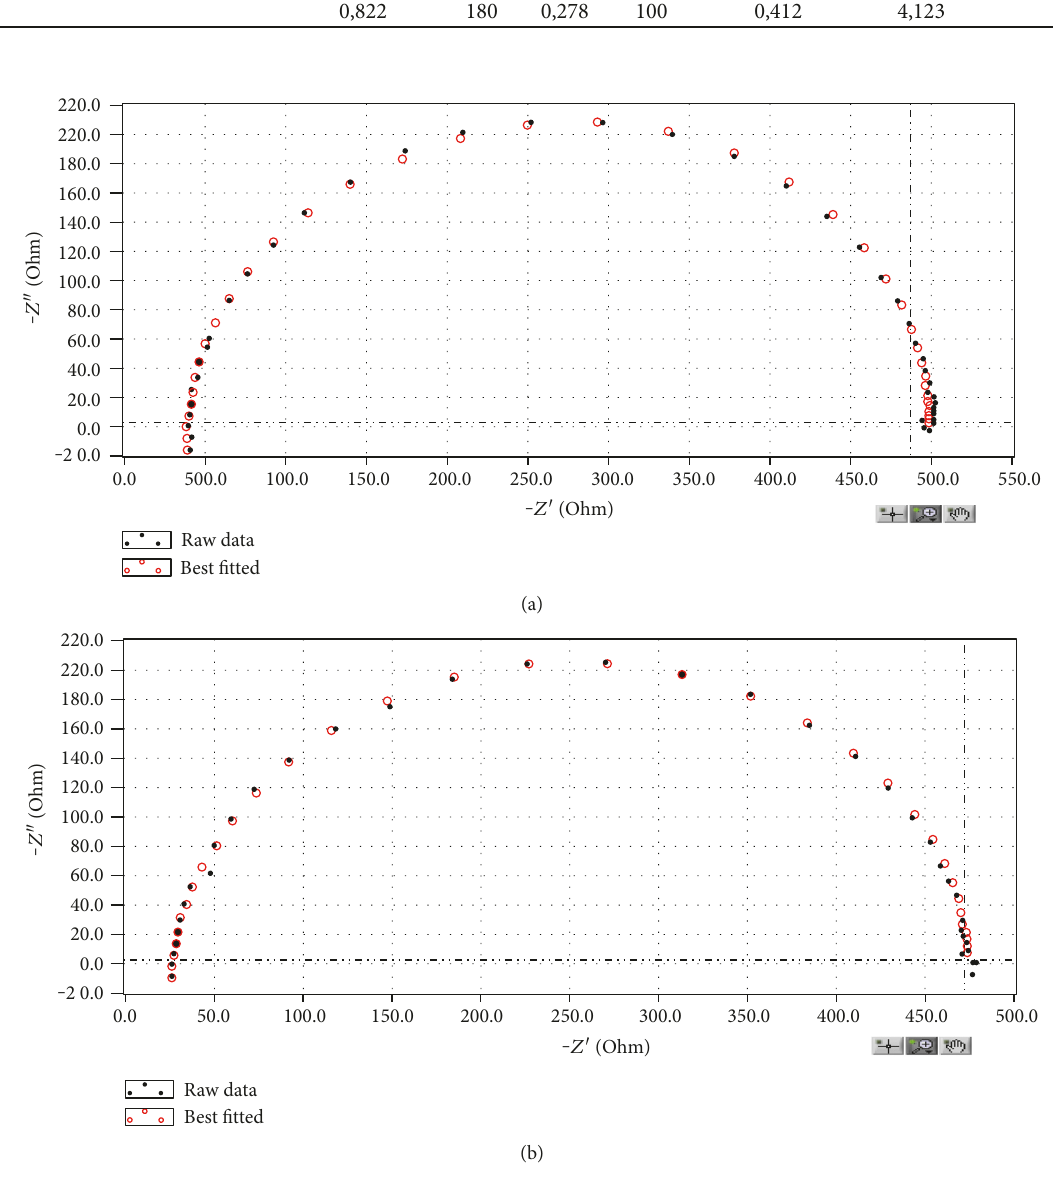
Figure 12: Device 5 fi nger 2 time-dependent voltage degradation test impedance before (a) and after (b)